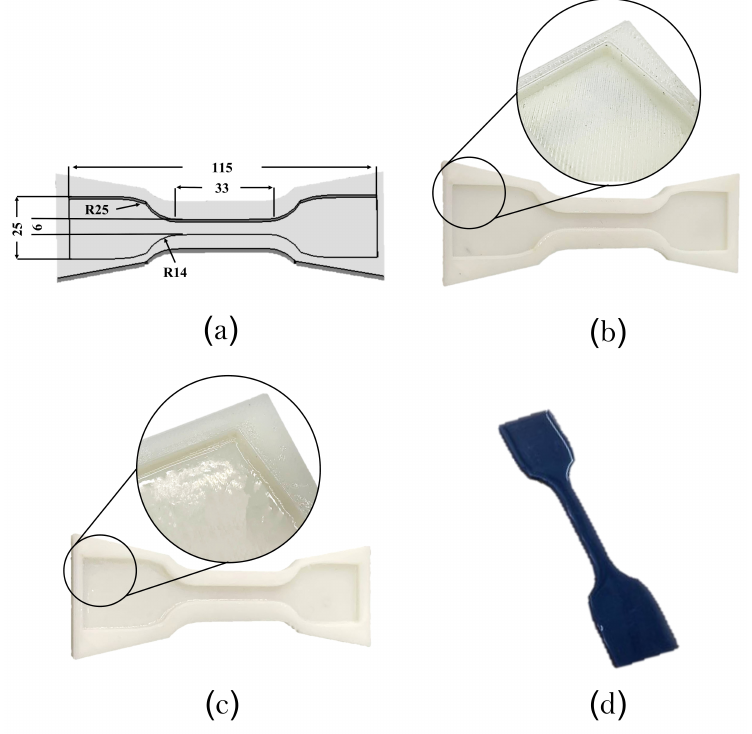
Figure 2. The fabrication process of the elastomer testing specimen. ( a ) CAD model of the specimen mould showing the specimen dimensions in mm. ( b ) 3D-printed mould showing the poor surface finish. ( c ) The specimen mould after acetone curing improves the surface quality. ( d ) Elastomer sample after curing and readying for tensile